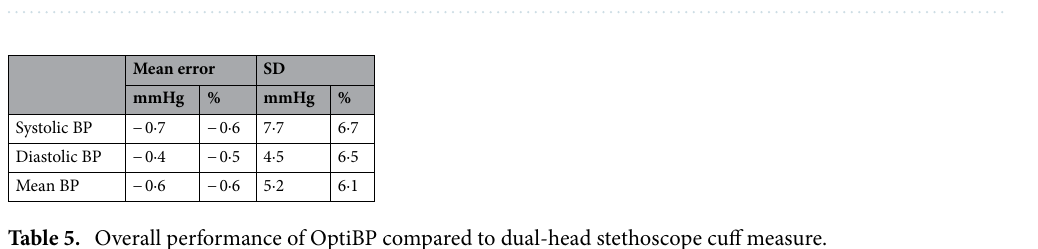
Figure 3. CONSORT Flow Chart of signals used for validation. 1 SAP > 12 mmHg or DAP > 8 mmHg.